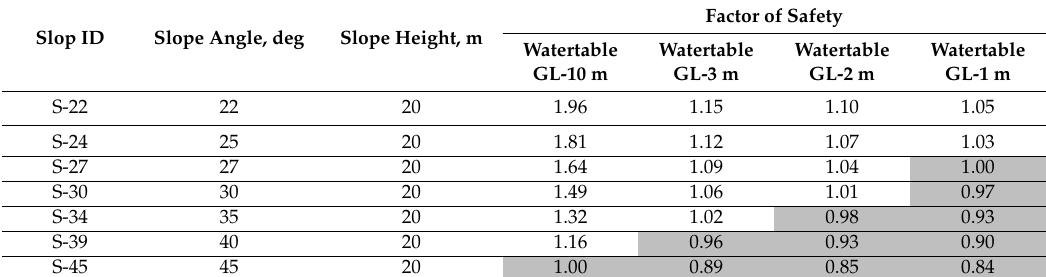
Table 2. Summary of factors of safety depending on slope angles and groundwater tables.